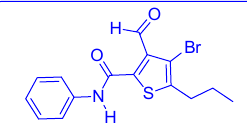
Figure 1. 4-Bromo-3-formyl- N -phenyl-5-propylthiophene-2-carboxamide.